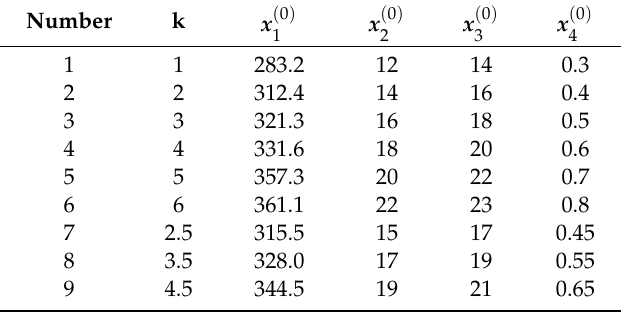
Table 5. E ff ect of simultaneous changes of multiple factors on fiber